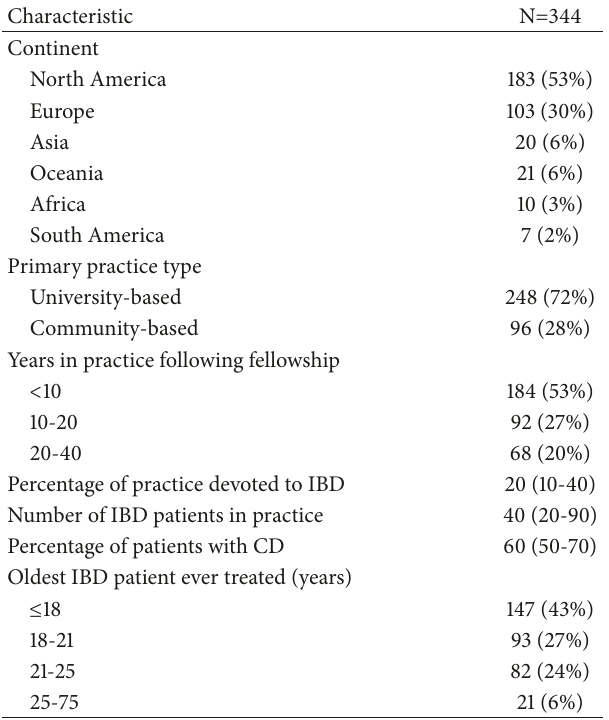
Table 1: Demographics for the 344 respondents who completed the survey. Results are presented as N (%) or median (interquartile range) as